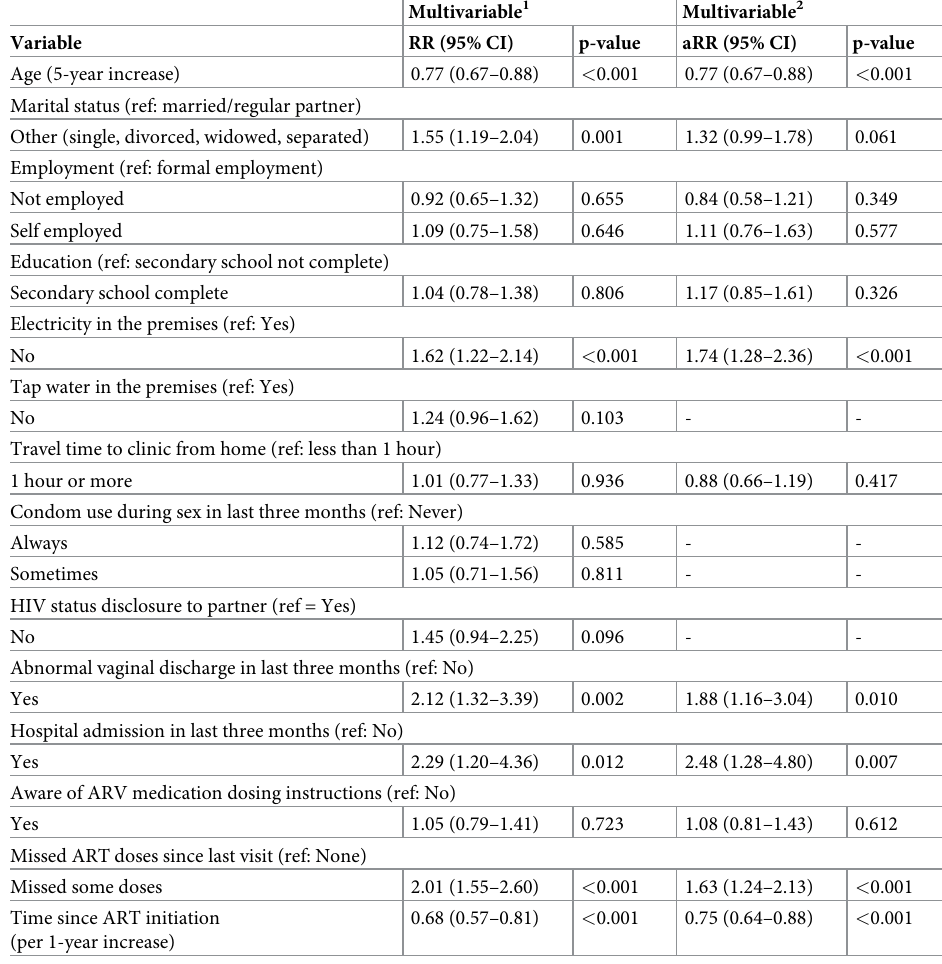
Table 2. Factors associated with detectable viral load > 200